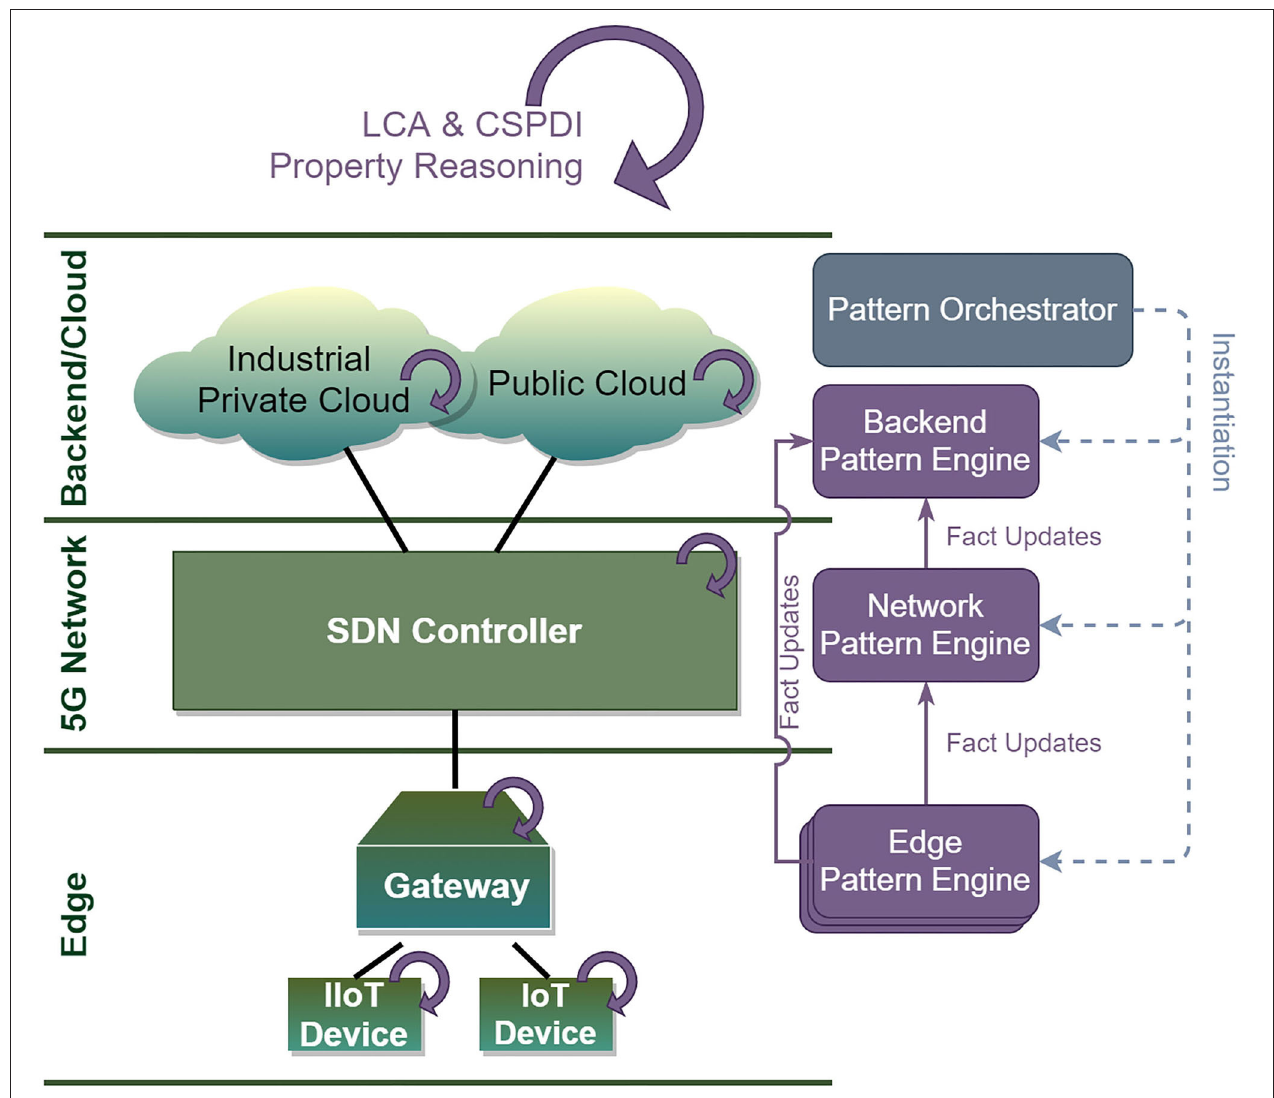
FIGURE 2 | CIRCE high-level